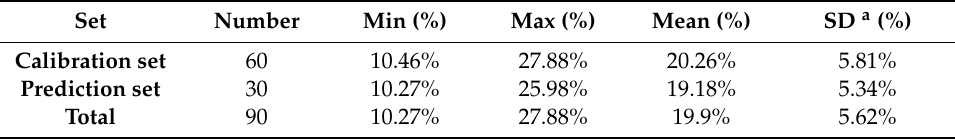
Table 1. Statistical description of the moisture content in rice grain samples.